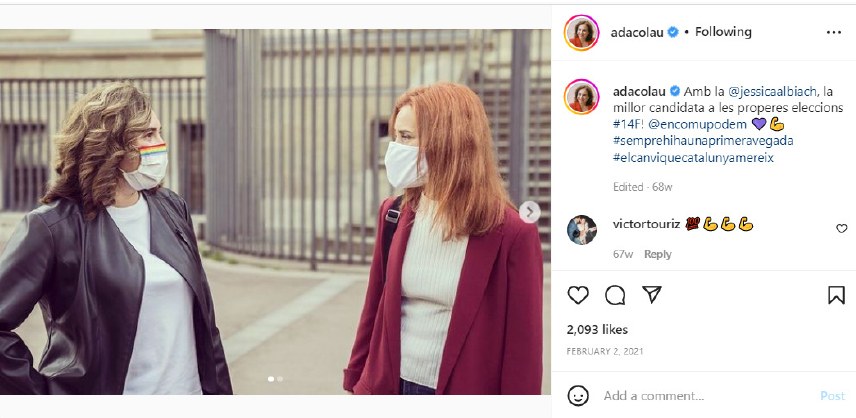
Figure 6. Colau wearing a mask with the LGBIT+ flag on February 2,